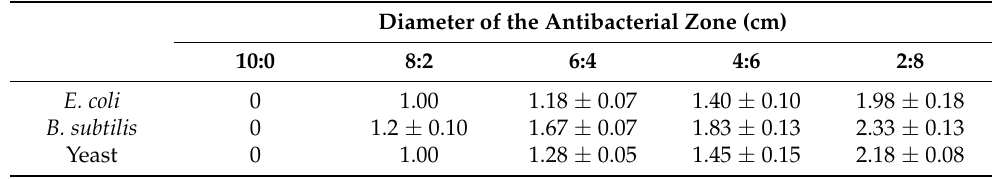
Table 1. Diameter of the antimicrobial zones on the films exposed to three